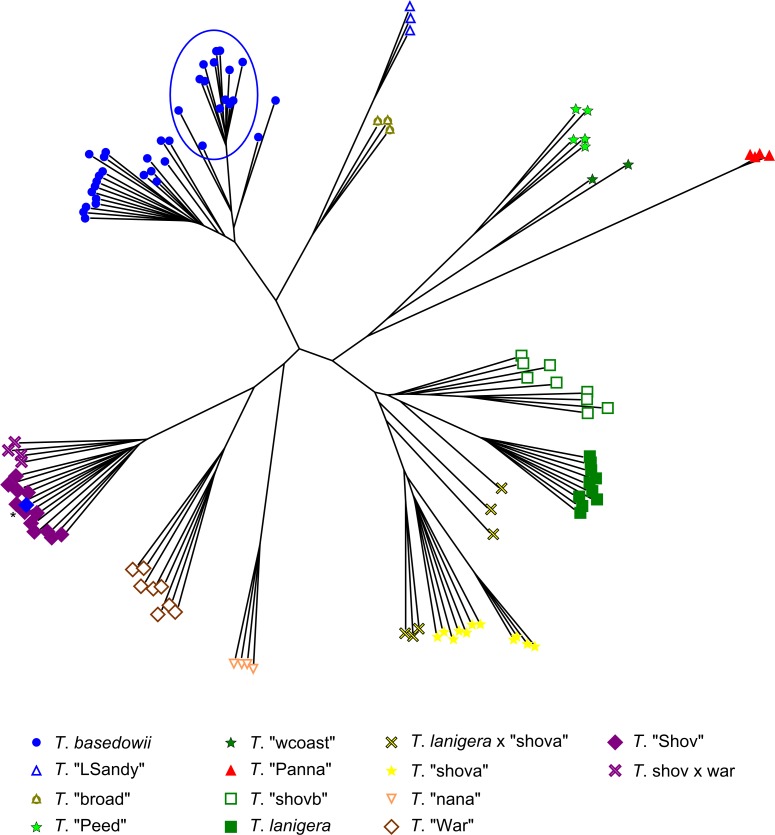
Neighbour-joining tree for samples from the Triodia basedowii complex.Distances are based on 119,449 SNPs, after filtering for 50% minimum taxon coverage and removing invariant SNPs. T. basedowii populations from central Australia are circled. The asterisked sample (blue diamond) was likely mislabelled as T. basedowii in the field (co-occurring with T. "Shov") and is probably a T. "Shov" sample.